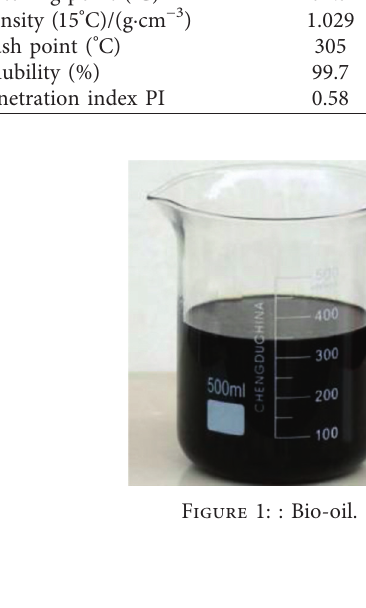
Table 2: Performance indexes of bio-oil.